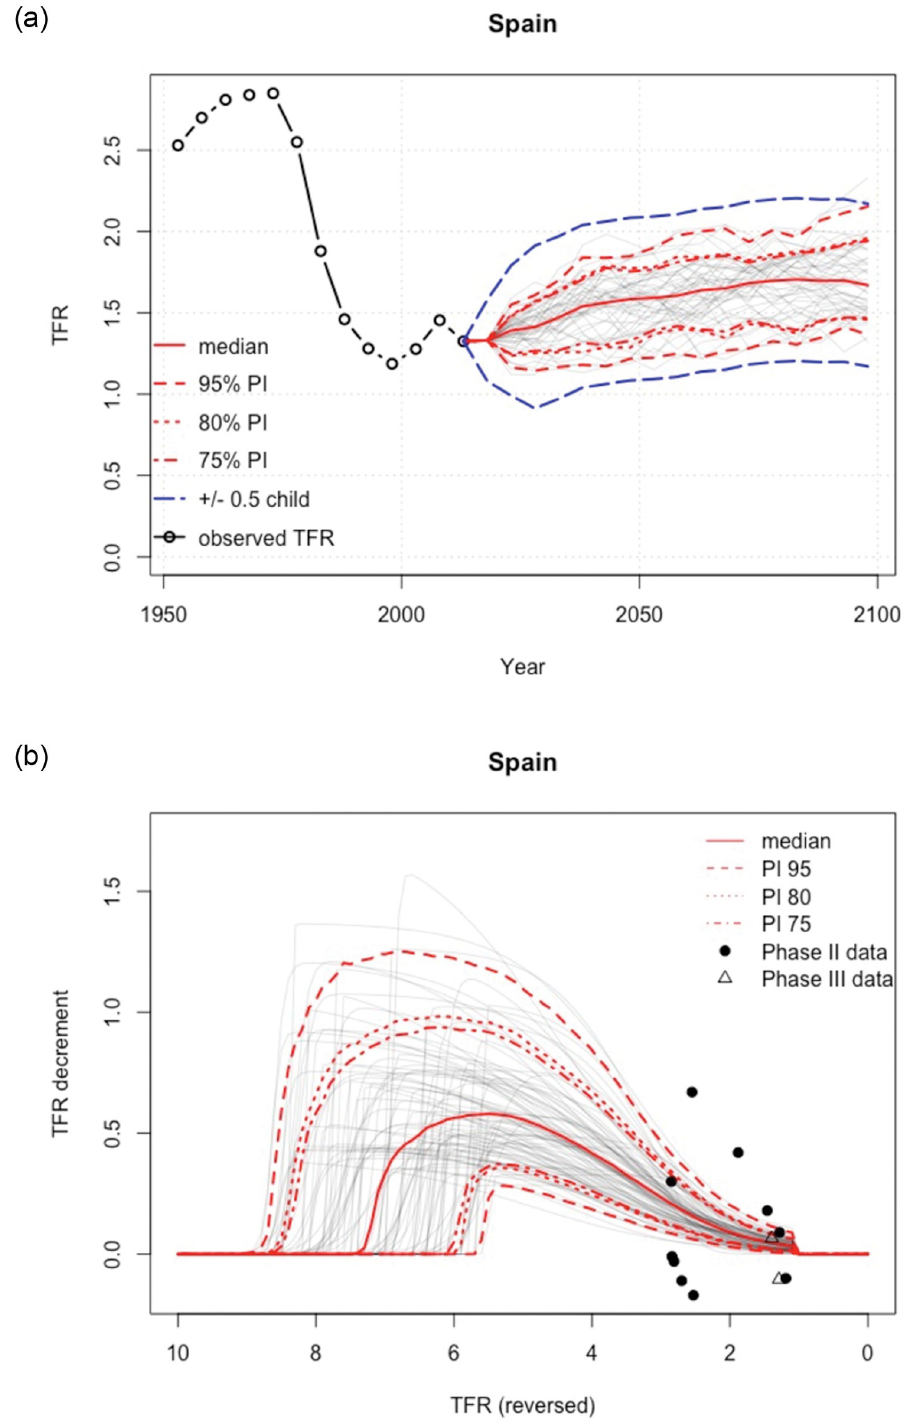
Fig 6. Probabilistic projections of TFR. TFR projections: median, 80%, and 95% prediction intervals and high/low fertility variant (left); Probabilistic projections of total fertility. Decline curves (based on the double logistic function) from the Bayesian hierarchical model, Median, 80% and 95% prediction intervals (right). Source: own elaboration.